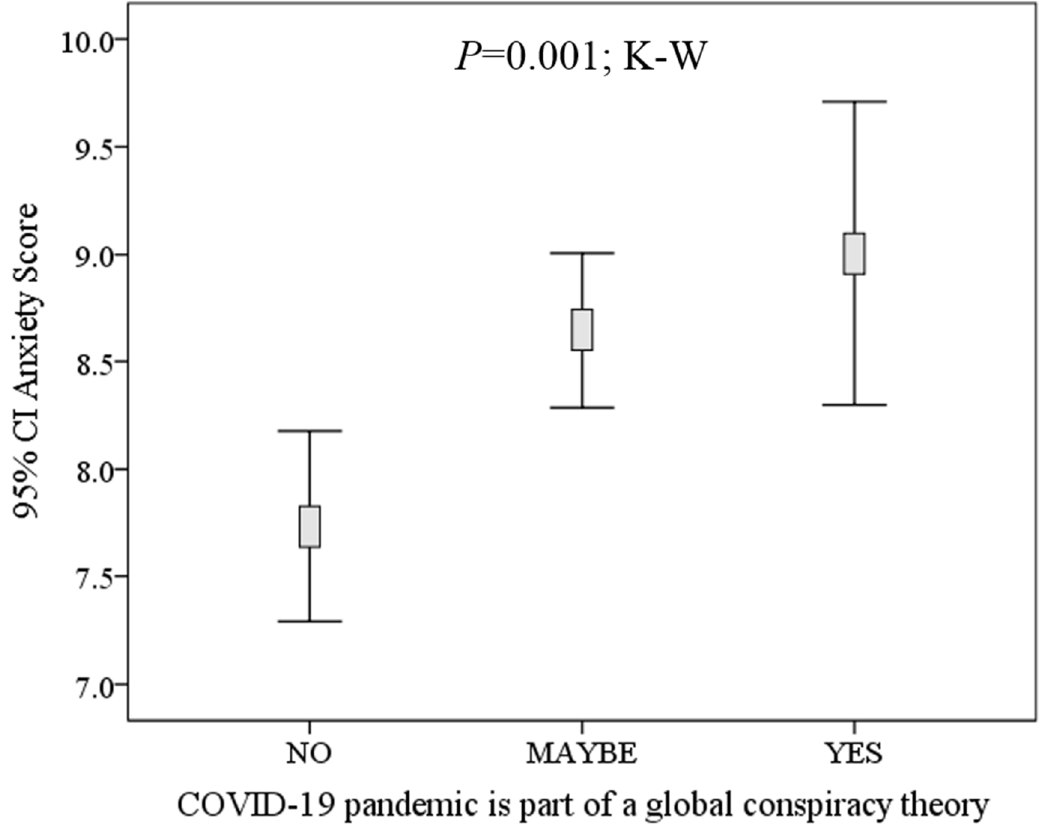
Figure 3. Correlation between students’ anxiety about COVID-19 and their belief in a conspiracy role in the disease. Participants were students at the University of Jordan. K–W: Kruskal–Wallis test. CI: confidence